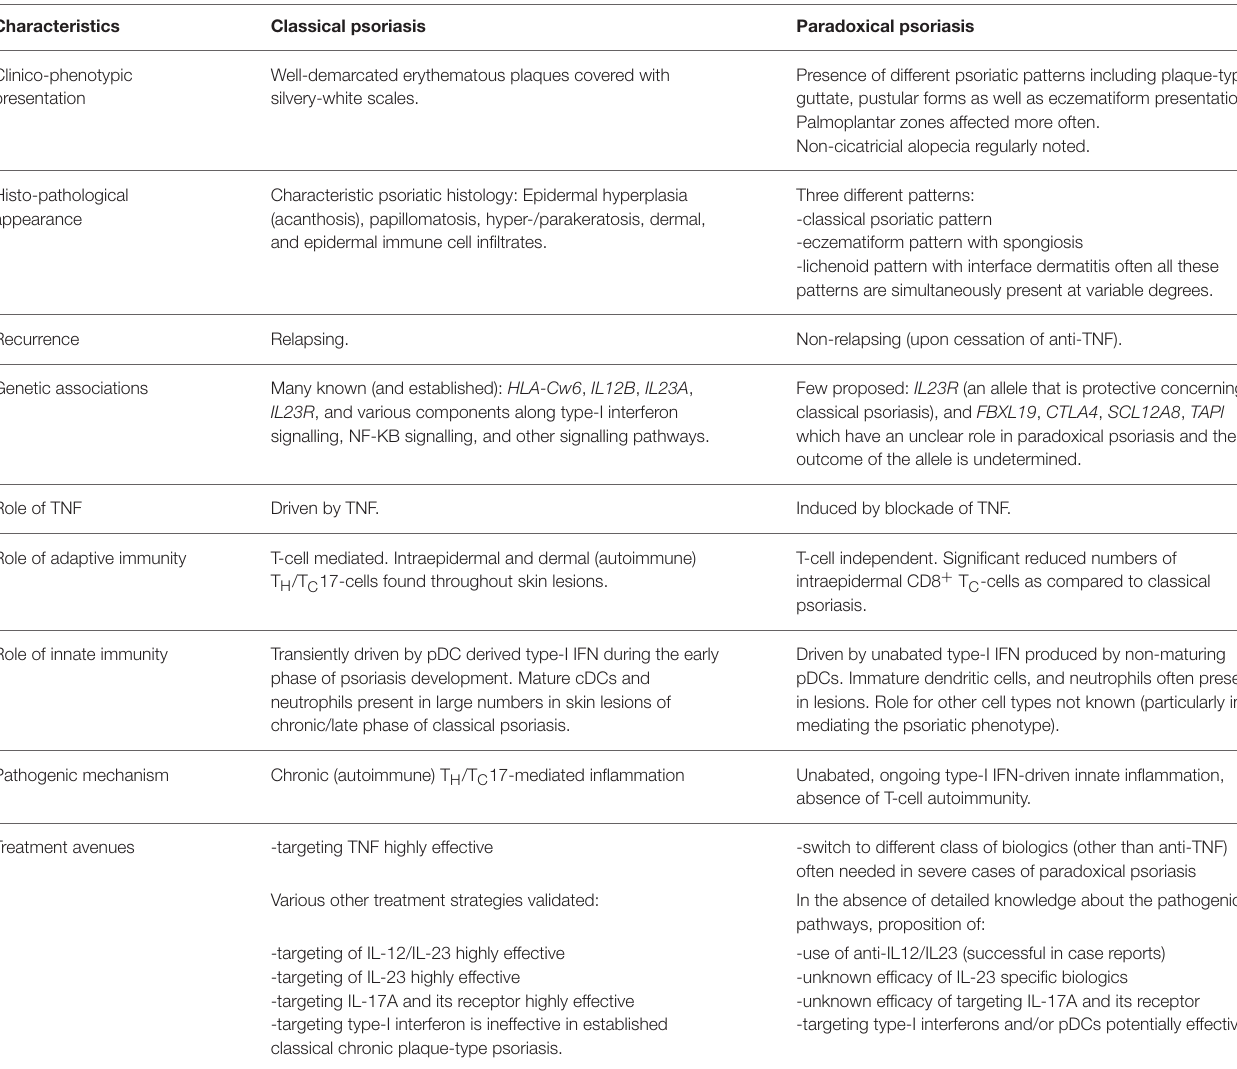
TABLE 1 | Classical vs. Paradoxical psoriasis- differences, similarities, and treatment strategies.